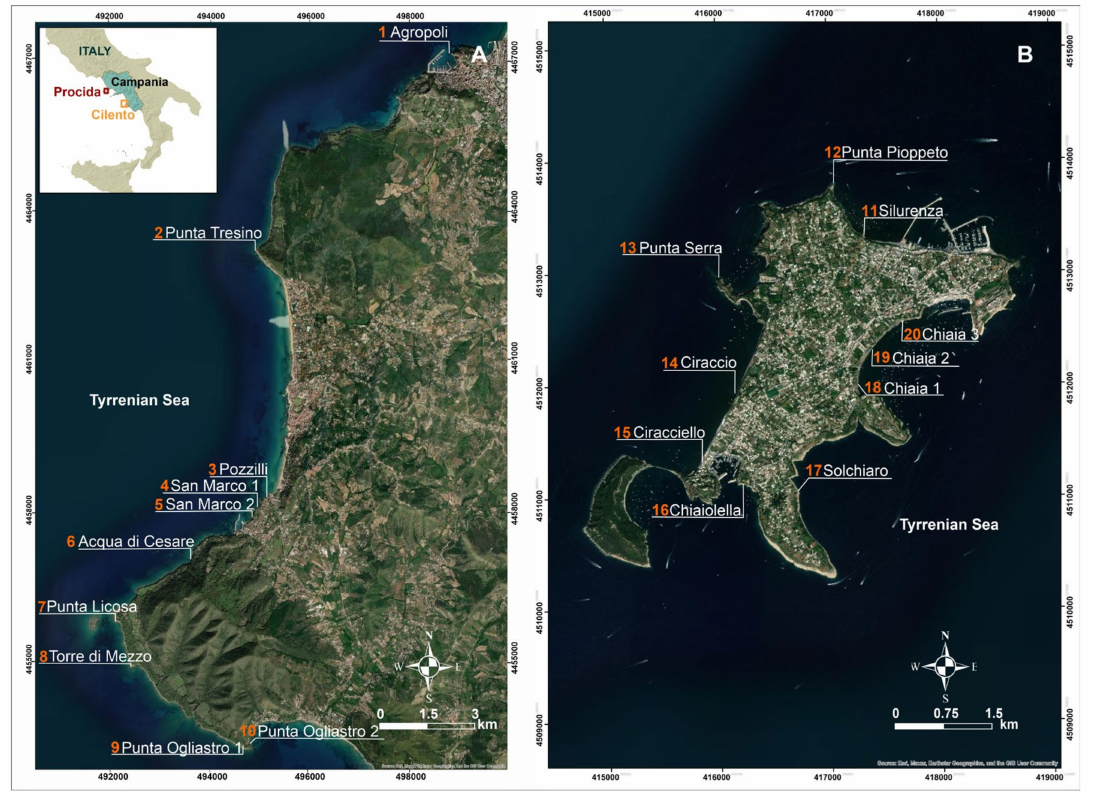
Figure 1. Location map of the 10 sites investigated along the Cilento coast ( A ) and the 10 sites located along the island of Procida ( B